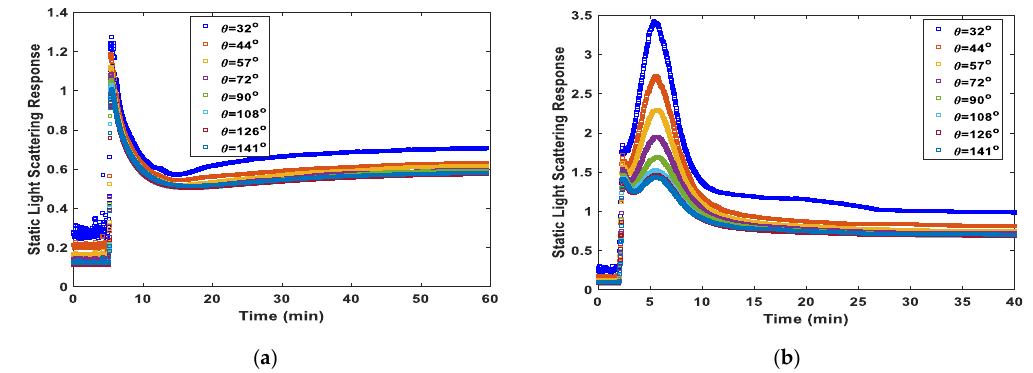
Figure 9. Typical results concerning the in-line static light scattering monitoring of polyacrylamide homopolymers and hydrogel formation processes. ( a ) Homopolymer L4. ( b ) Hydrogel H6.